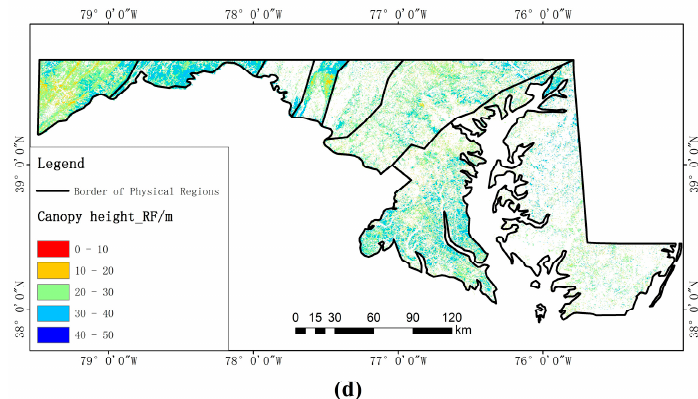
Figure 6. The distribution of forest canopy height in Maryland. ( a ) Forest canopy height estimated by the first principal component power model; ( b ) Forest canopy height estimated by the BPANN model; ( c ) Forest canopy height estimated by the SVR model; and ( d ) Forest canopy height estimated by the RF model.